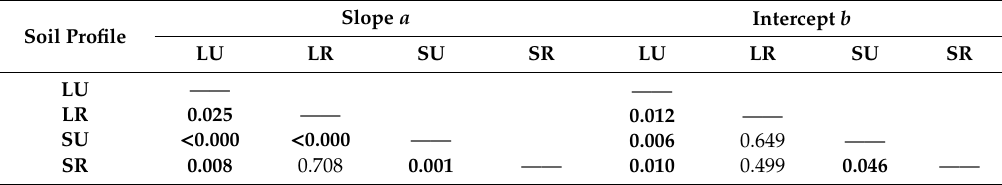
Figure 8. Linear increase of soil organic carbon (SOC) 14 C apparent age with soil depth in the four soil profiles (LU, LR, SU and SR) in a montane subtropical moist forest of southwestern China. Note, we excluded the data from the bottom two soil layers in the SR soil profile because of their apparent abnormalities (the two values in the circle). Table 2. Statistical significance ( p –value) of two parameters (slope a and intercept b ) in the linear increase function between soil organic carbon 14 C apparent age and soil depth in the four soil profiles (LU, LR, SU and SR) in a montane subtropical moist forest of southwestern China. Bold indicates p < 0.05.